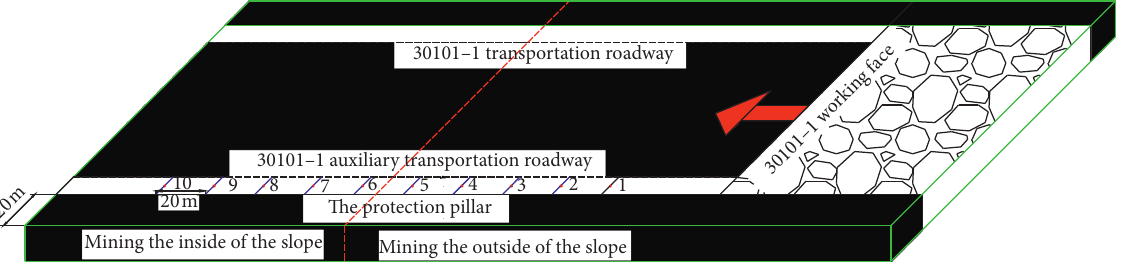
Figure 9: The comprehensive measuring monitoring station layout plan.